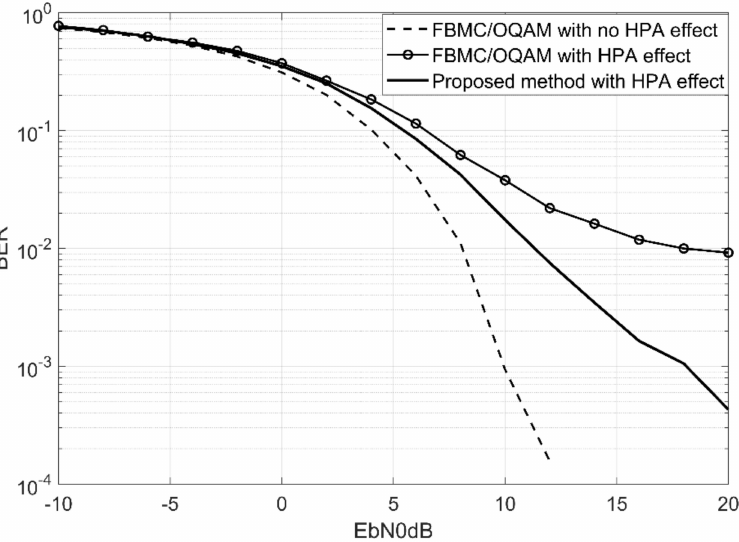
Figure 8. BER (bit-error-rate) comparison with HPA (high-power amplifier) effect for IBO = 3 dB (input